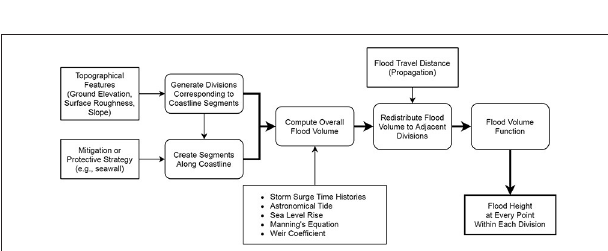
FIGURE 2 | The GISSR flood simulation schematic diagram. Rectangles indicate inputs and rounded rectangles indicate